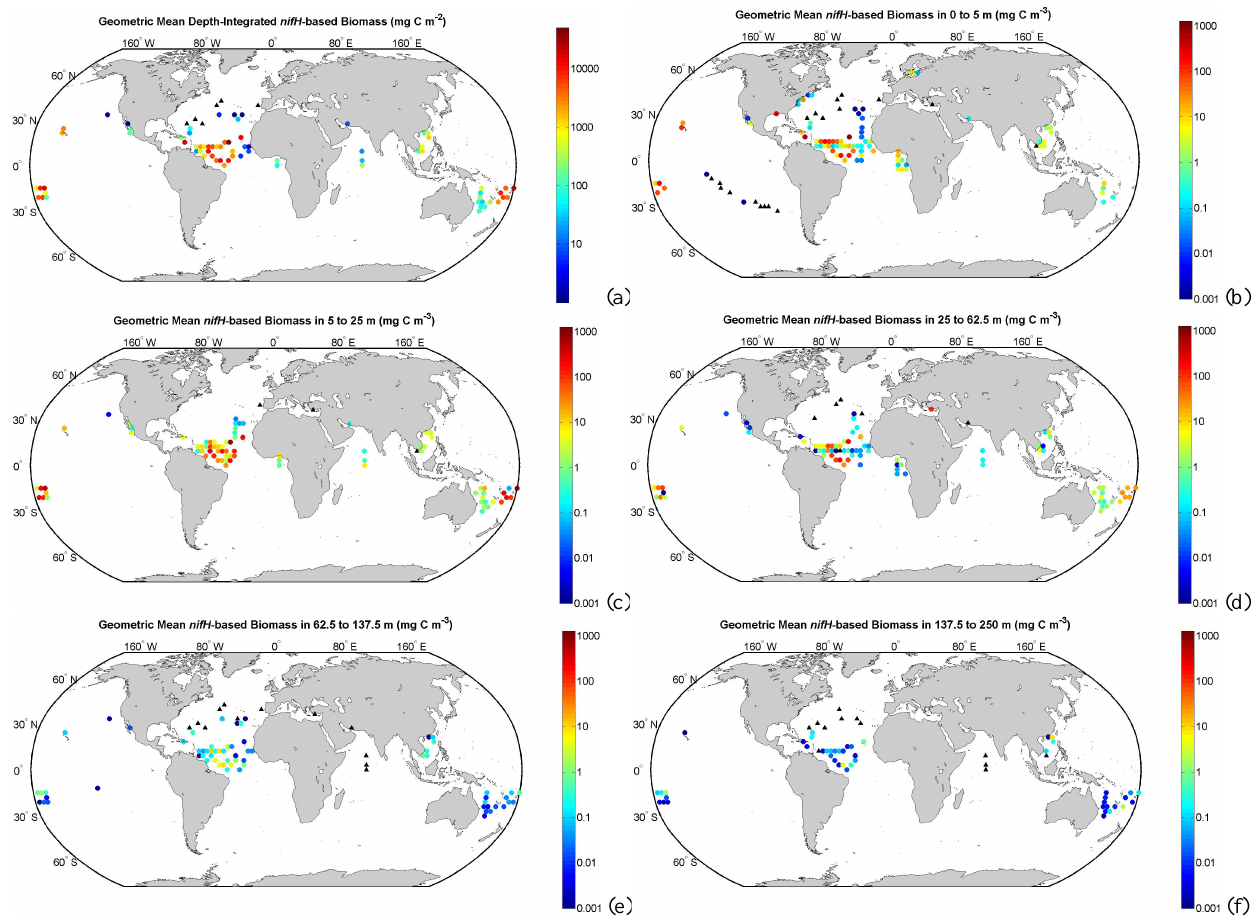
Figure 9. (a) Geometric mean depth-integrated nifH -based diazotrophic carbon biomass binned on 3 ◦ × 3 ◦ grid. Also geometric mean nifH - based diazotrophic carbon biomass on 3 ◦ × 3 ◦ grid for 5 vertical layers of (b) 0–5m, (c) 5–25m, (d) 25–62.5m, (e) 62.5–137.5m and (f) 137.5–250m. The color bar is in logarithmic scale. Zero values are marked with black triangles. Table 6. Estimates of N 2 fixation rate for the global oceans based on geometric and arithmetic means. Note that data points with zero- values are excluded when calculating geometric means. Depth-integrated N 2 fixation rates are first binned to 3 ◦ × 3 ◦ grid, and geometric and arithmetic means are calculated for each bin, which are then used to calculate geometric and arithmetic means for each region. Areal sum is calculated by multiplying geometric or arithmetic means with ocean area. Error ranges for geometric means shown in parentheses are estimated by dividing and multiplying the geometric means by one geometric standard error. Standard errors for arithmetic means are shown in parentheses. Error range for global geometric mean is estimated by simply summing lower and upper bounds of the error ranges of each region. Errors for global arithmetic means are propagated from (independent) errors in each region. ND: no data. NQ: not qualified to calculate areal sum because of too few